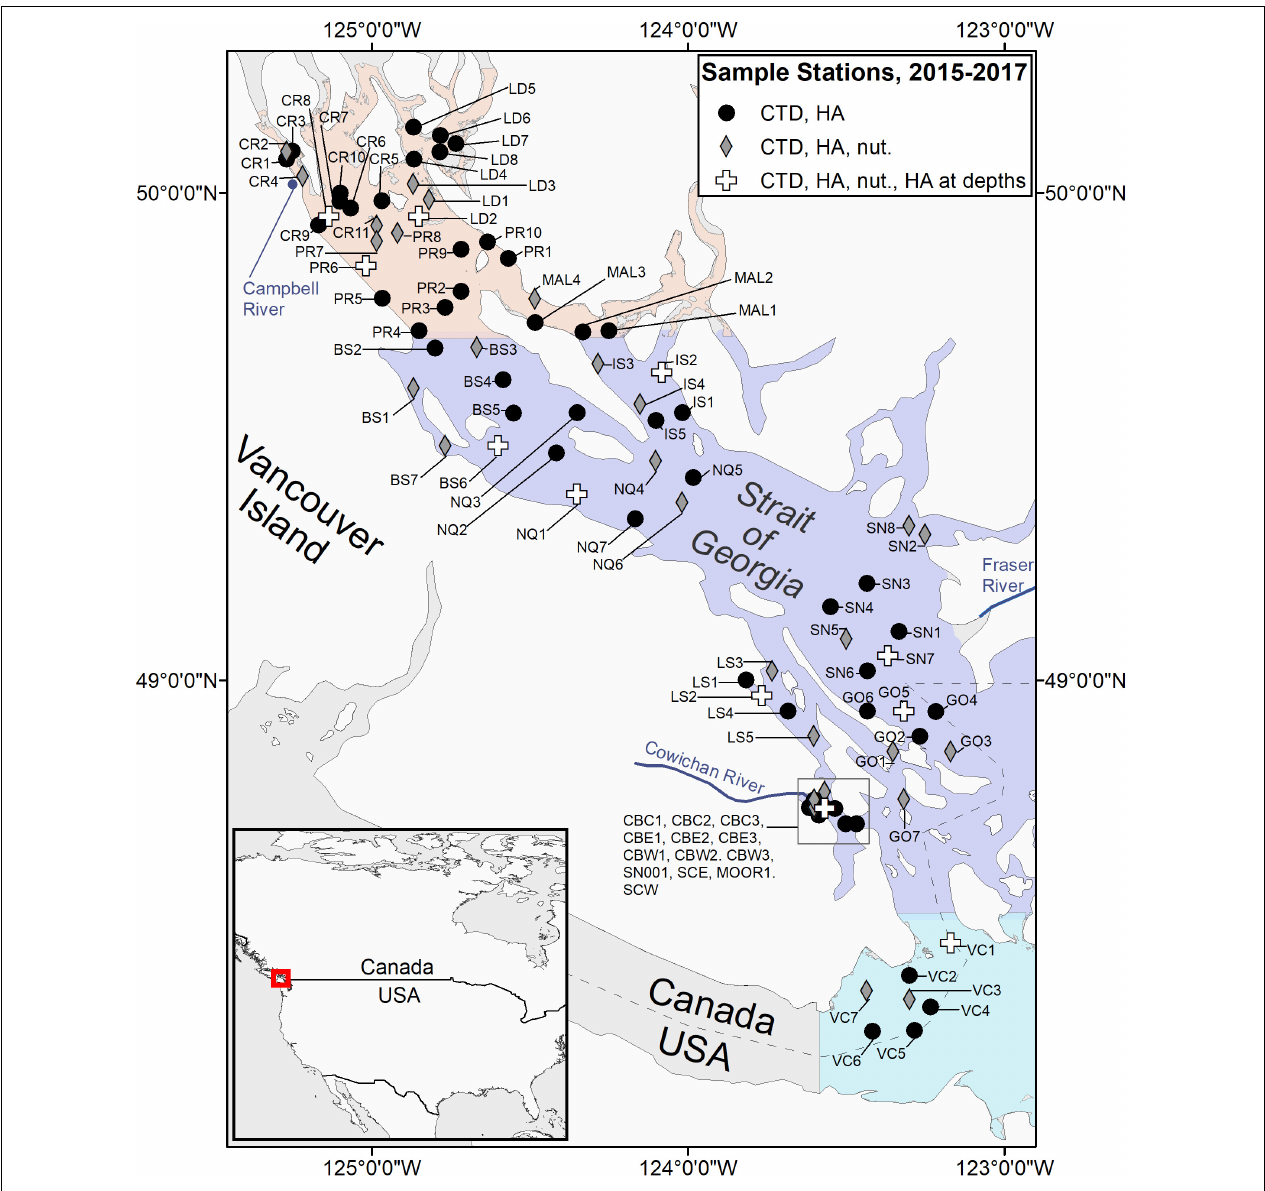
FIGURE 1 | Map of the sampling locations. Shading represents southern, central and northern parts of the Strait of